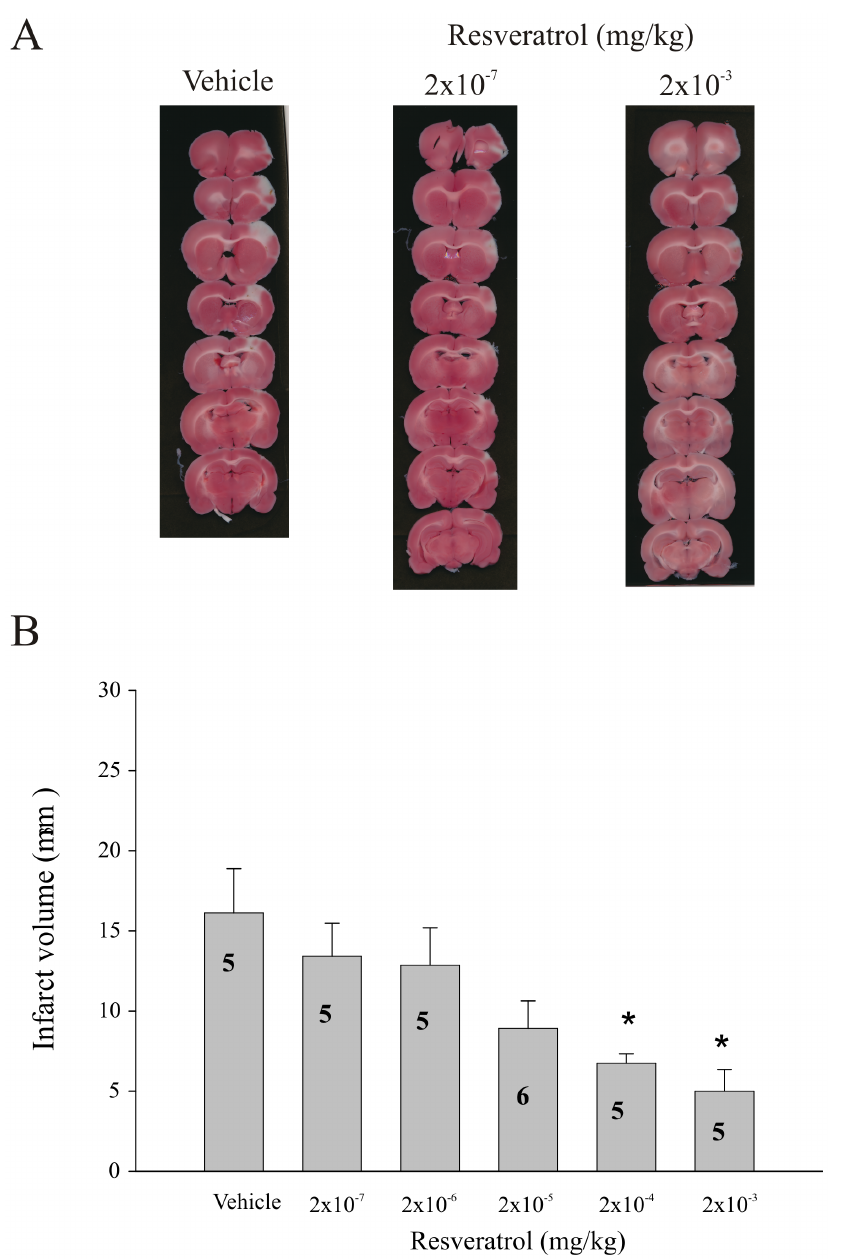
Figure 1. Dose-dependent effect of resveratrol on infarct volume following transient ischemia/reperfusion. (A) Representative photomicrographs of TTC-stained, 1 mm thick coronal slices illustrating the extent of infarct within the prefrontal cortex following pretreatment (30 minutes prior to MCAO; i.v.) with either Vehicle (propylene glycol 4 6 10 2 3% (v/v)) or Resveratrol (2 6 10 2 7 and 2 6 10 2 3 mg/kg) following ischemia/ reperfusion (tMCAO). (B) Bar graph summarizing the dose-response relationship between increasing doses of resveratrol and infarct size (mm 3 ) calculated from TTC-stained, 1 mm thick coronal sections following tMCAO. Each bar represents the mean 6 S.E.M. (n=5–6/group) and * indicates significance ( p # 0.05) from the vehicle-treated control